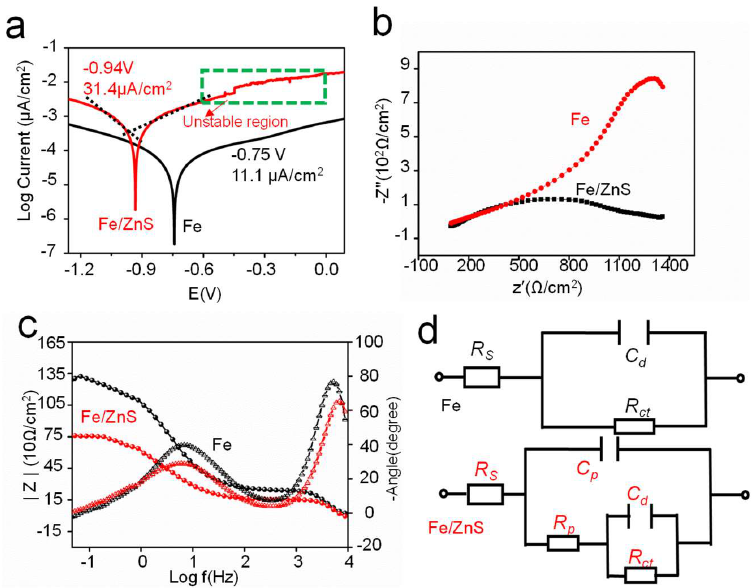
Figure 4. ( a ) The potentiodynamic polarization curves, ( b ) EIS spectra, ( c ) Bode plots and ( d ) the equivalent circuits obtained from electrochemical tests. equivalent circuits obtained from electrochemical